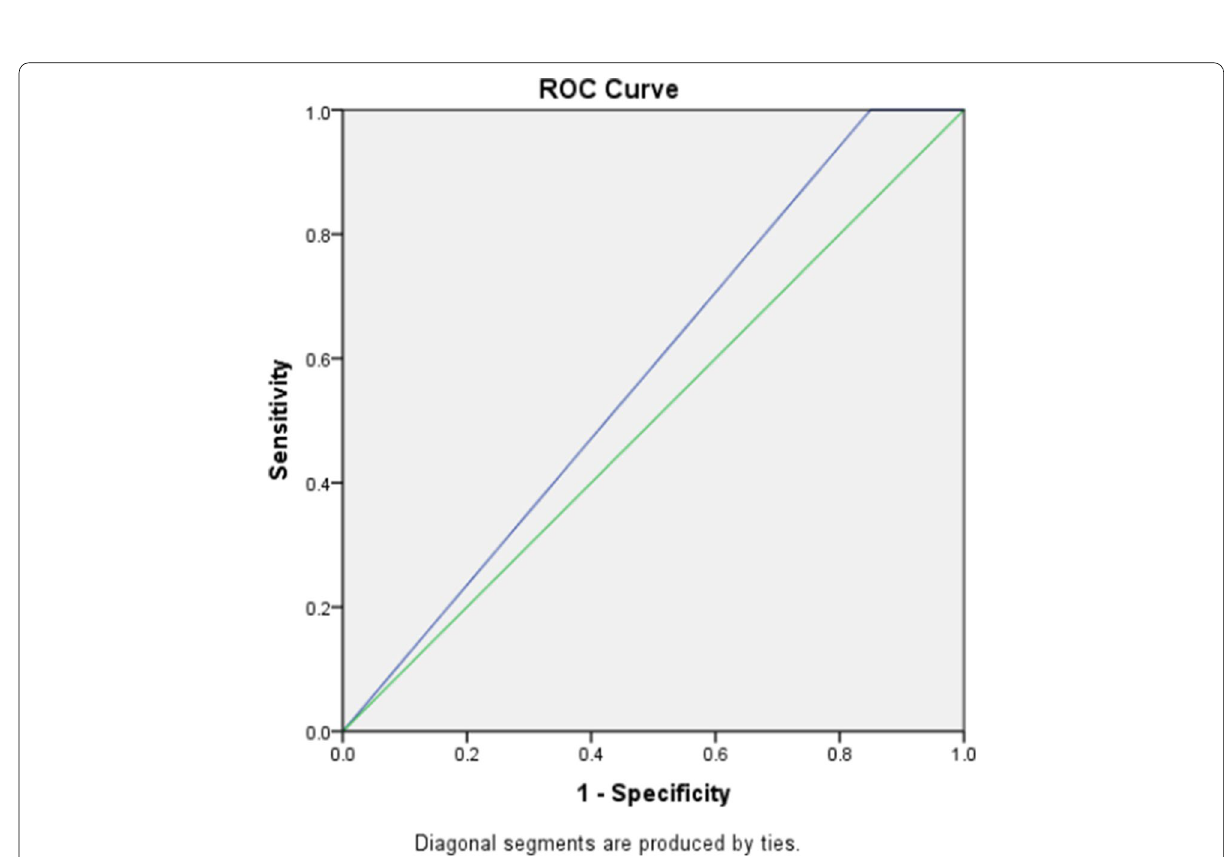
Fig. 1 ROC curve analysis for current HbA normal range of